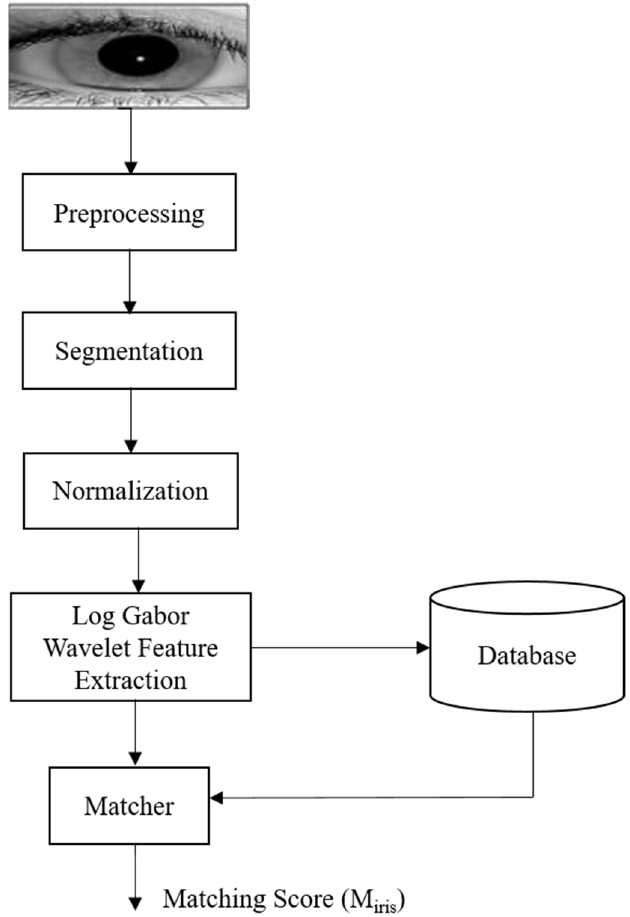
Figure 8. Iris recognition working by Daugman.